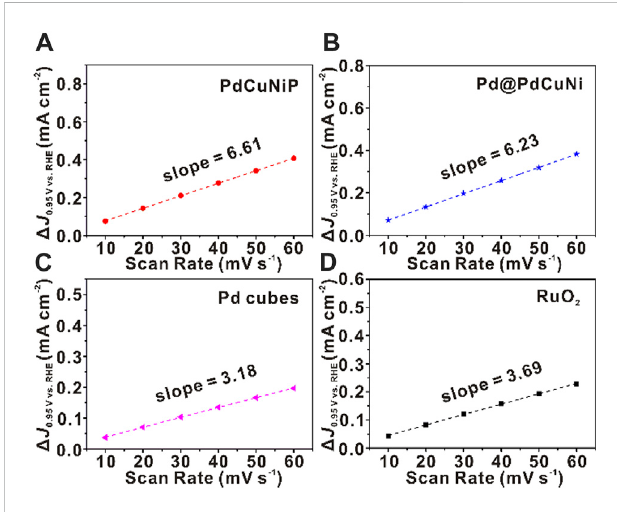
Measurements for electrochemical double-layer capacitance. Corresponding Δ J as a function of scan rates of (A) PdCuNiP, (B) Pd@ PdCuNi, (C) Pd nanocubes and (D) RuO 2